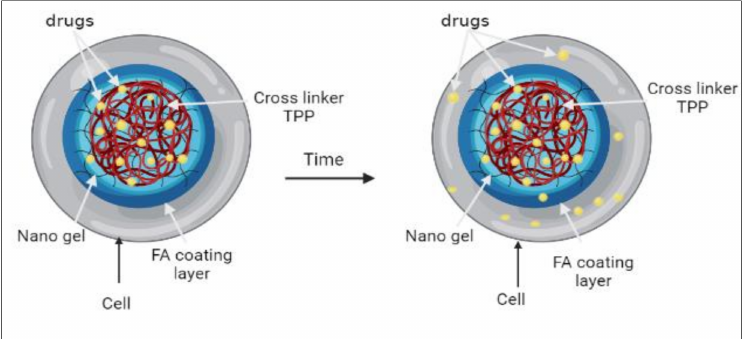
Table 2 represents the insulin drug entrapment of various CS-based hydrogel